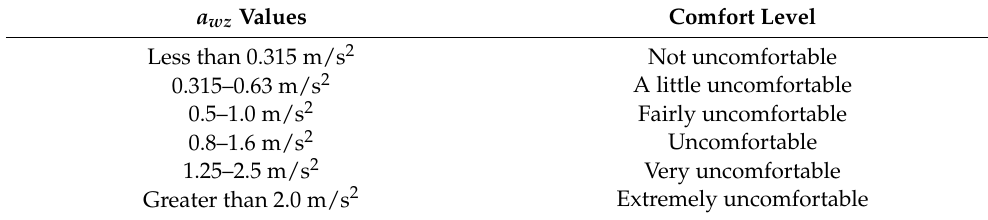
Table 1. Comfort levels and a wz threshold values according to ISO 2631-1